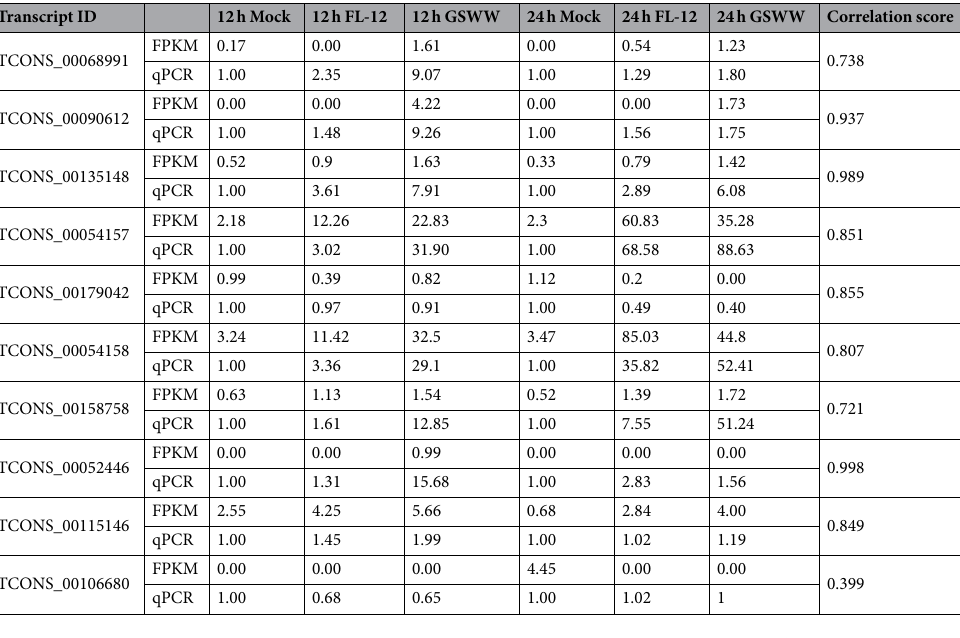
Table 1. Correlation analysis of RNA-seq and RT-qPCR results. Pearson correlation coefficients were calculated by GraphPad Prism 5.0 software.